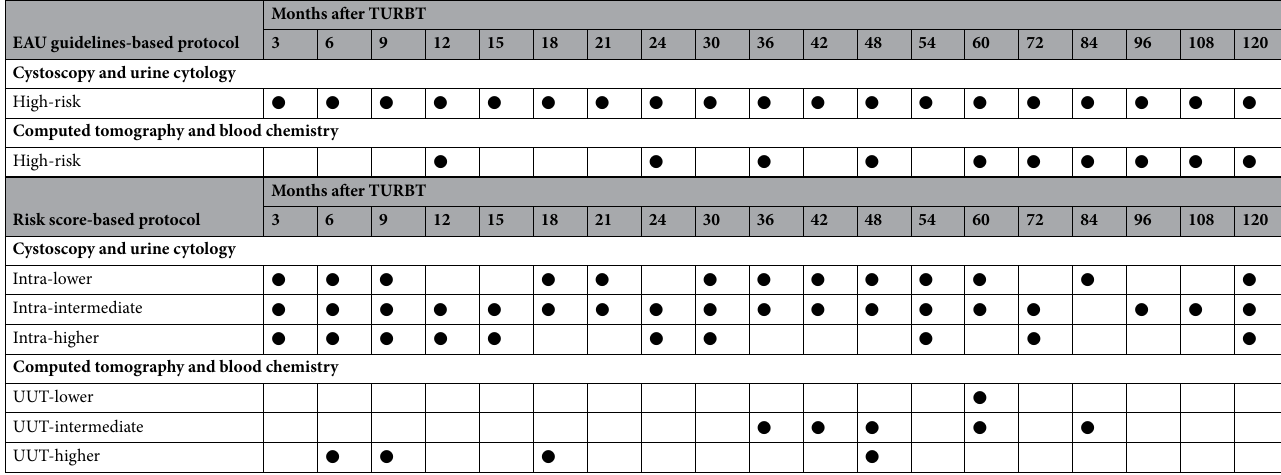
Table 1. Surveillance protocols. EAU, European Association of Urology; TURBT, transurethral resection of bladder tumor; UUT, upper urinary